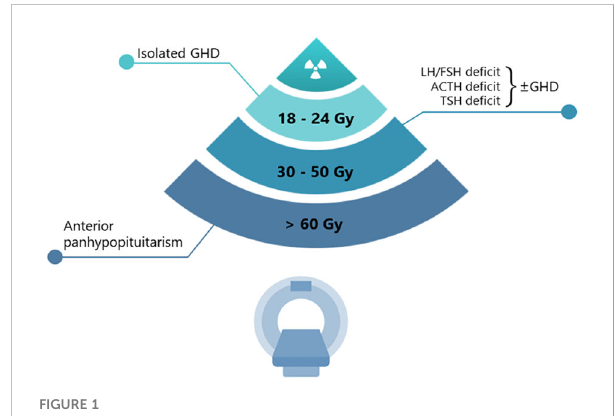
FIGURE 1 Radiation progressive damage of pituitary